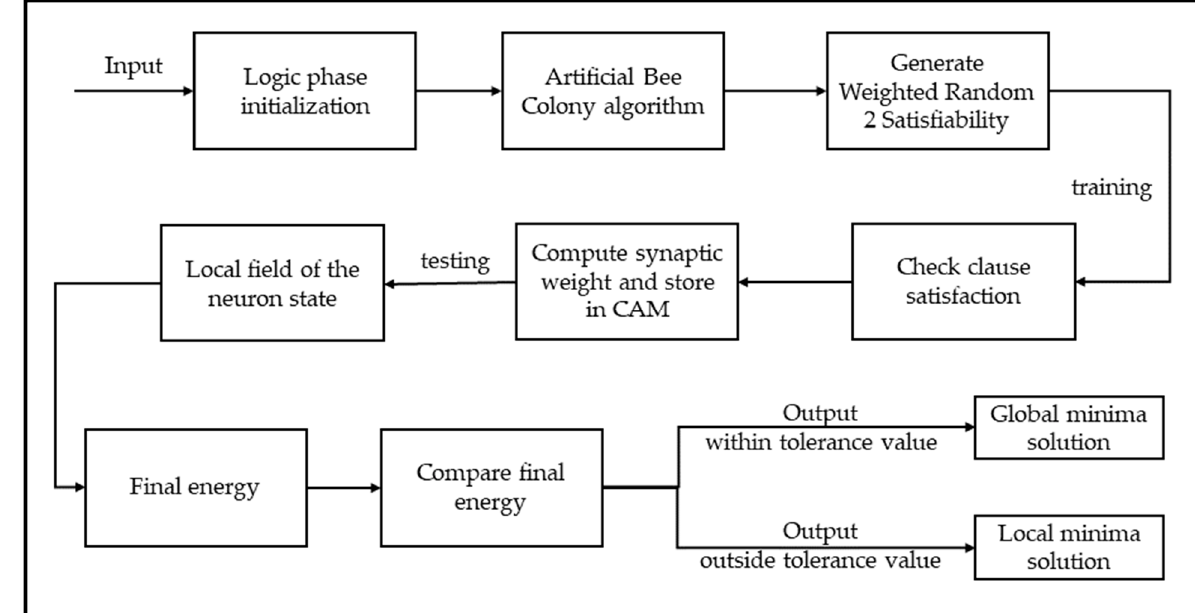
Figure 1. General Flow of the Proposed Study.